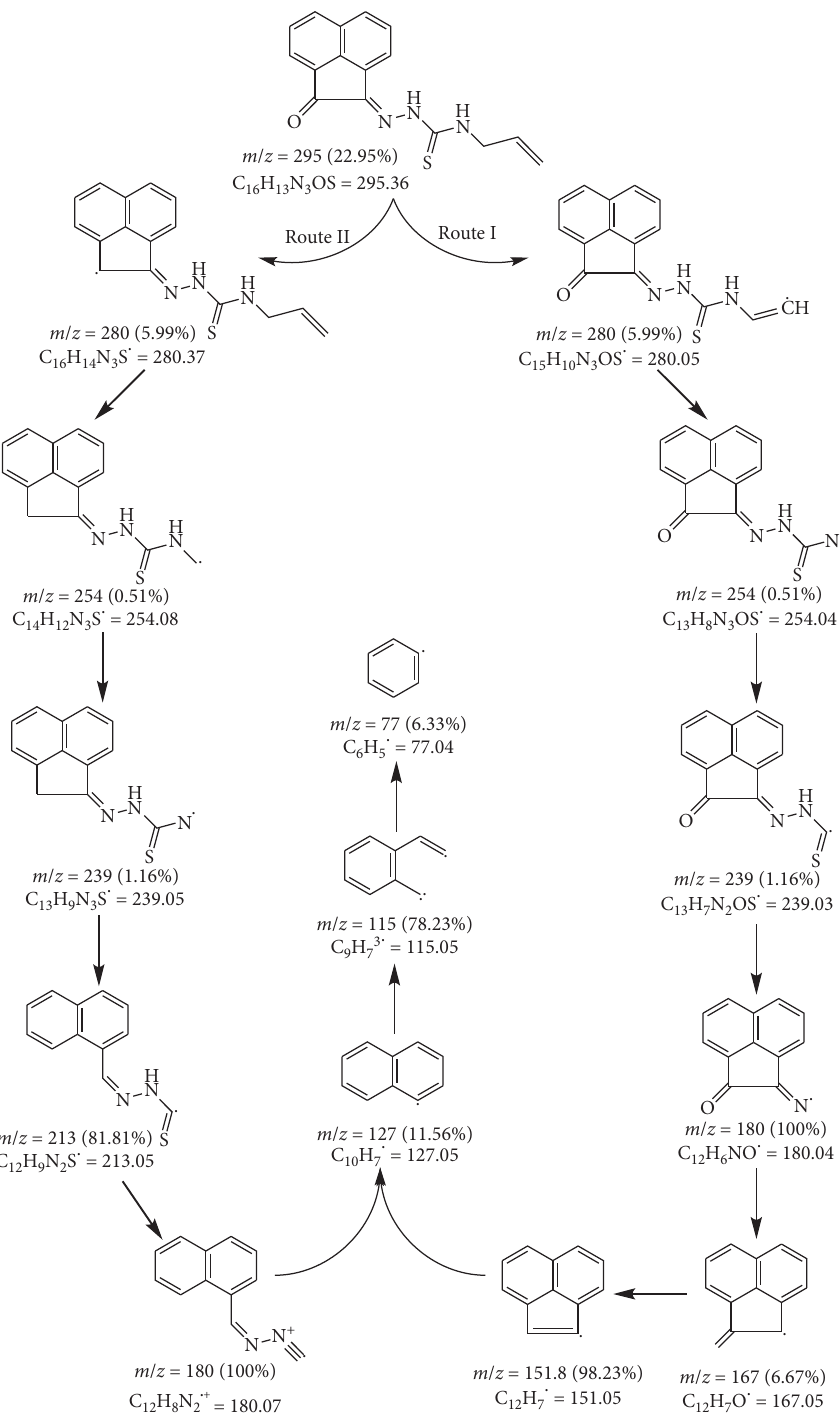
Scheme 1: Fragmentation pattern of